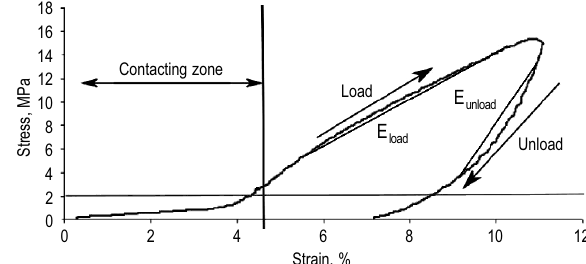
Table 1. Anisotropy ratio of Young’s modulus (E Young’s modulus and E Moisture ratio